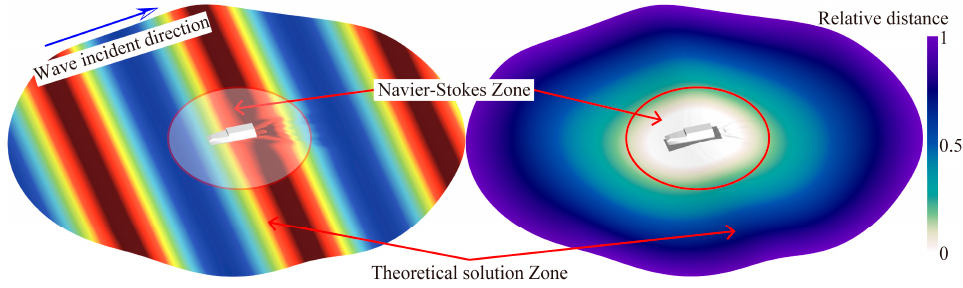
Figure 7. Illustration of the Euler overlay method in the cylindrical numerical wave tank. The incident direction of waves and the sailing direction of the USV is shown in Figure 8.